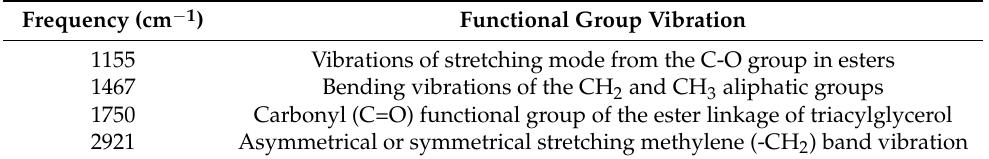
Figure 1. Spectrum analysis of pure pork identifying the frequencies for functional group vibrations. Table 4. Functional group and associated mode of vibration for pure lard.